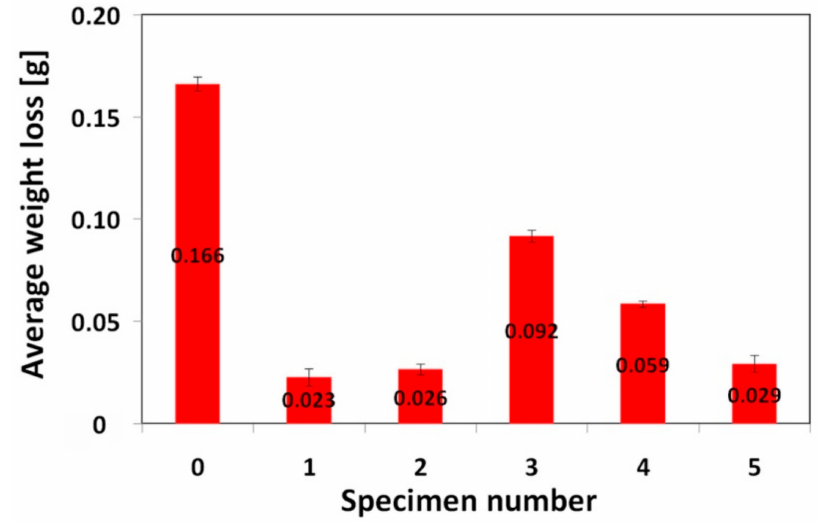
Figure 8. Average weight loss of investigated materials subjected to abrasive wear testing: 0—16MnCr5 steel; 1—“E520 RB” hardfacing; 2—“RD 571” hardfacing; 3—“LNM 420FM” hardfacing; 4—“E DUR 600” hardfacing; 5—“Weartrode 62” hardfacing.